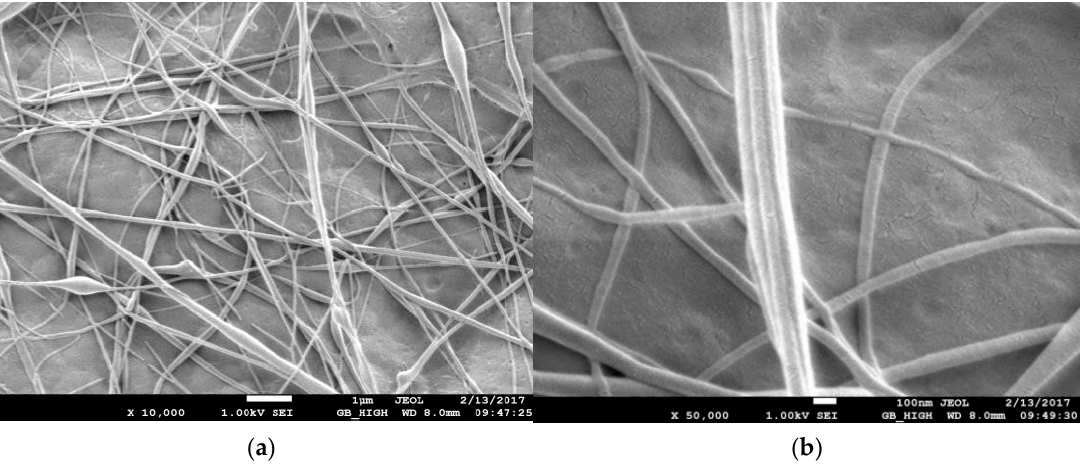
Figure 5. SEM images of pristine PVDF nanofibers ( a ) at 10,000 and ( b ) at 50,000 magnifications. The SEM images of the MWCNT-reinforced PVDF membrane can be seen in Figure 6.